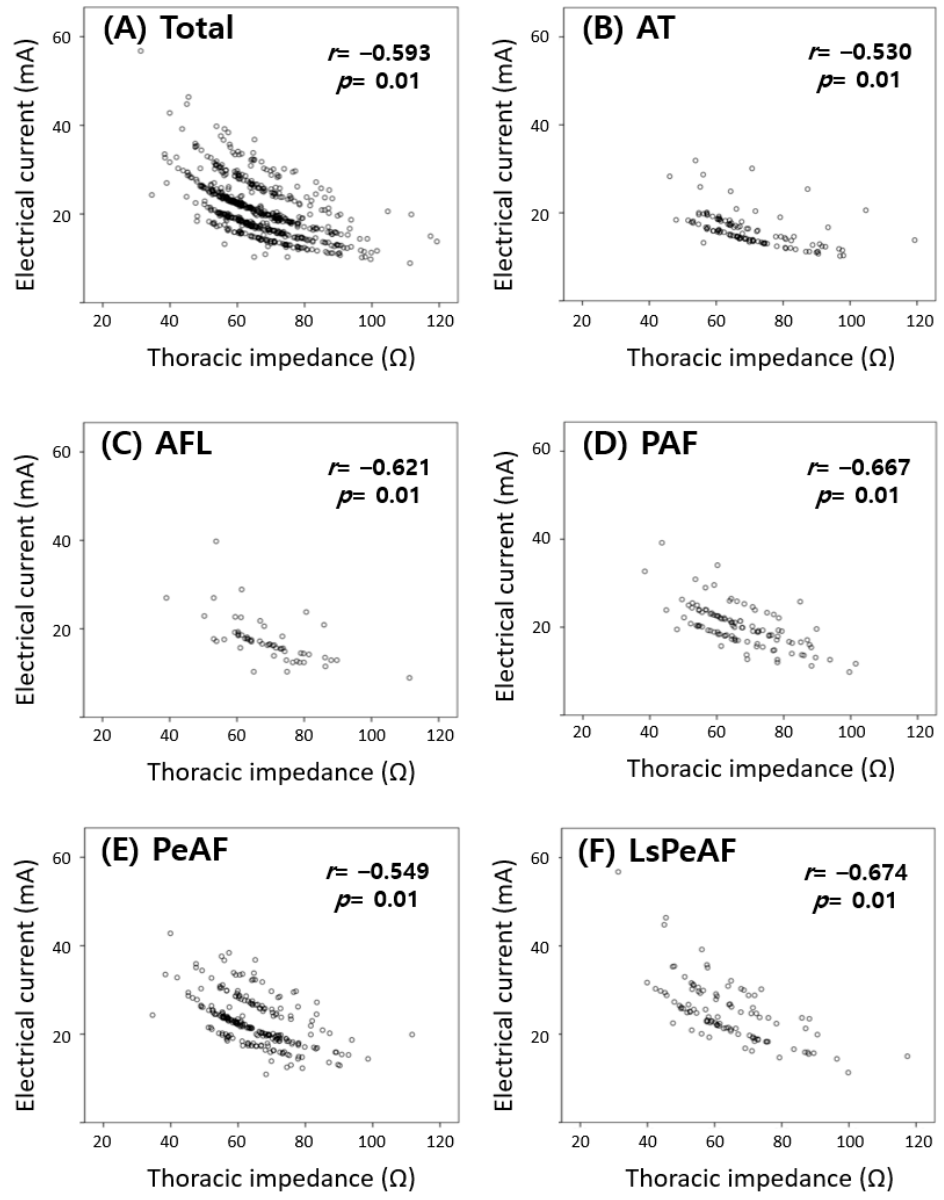
Figure 2. The relationship between electrical current and thoracic impedance for ( A ) all patients and patients with ( B ) atrial tachycardia, ( C ) atrial flutter, ( D ) paroxysmal atrial fibrillation, ( E ) persistent atrial fibrillation, and ( F ) long-standing persistent atrial fibrillation. As the thoracic impedance increases, the electrical current decreases.